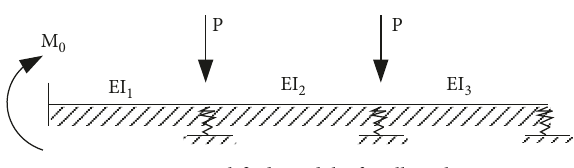
Figure 5: Simplified model of grille column.